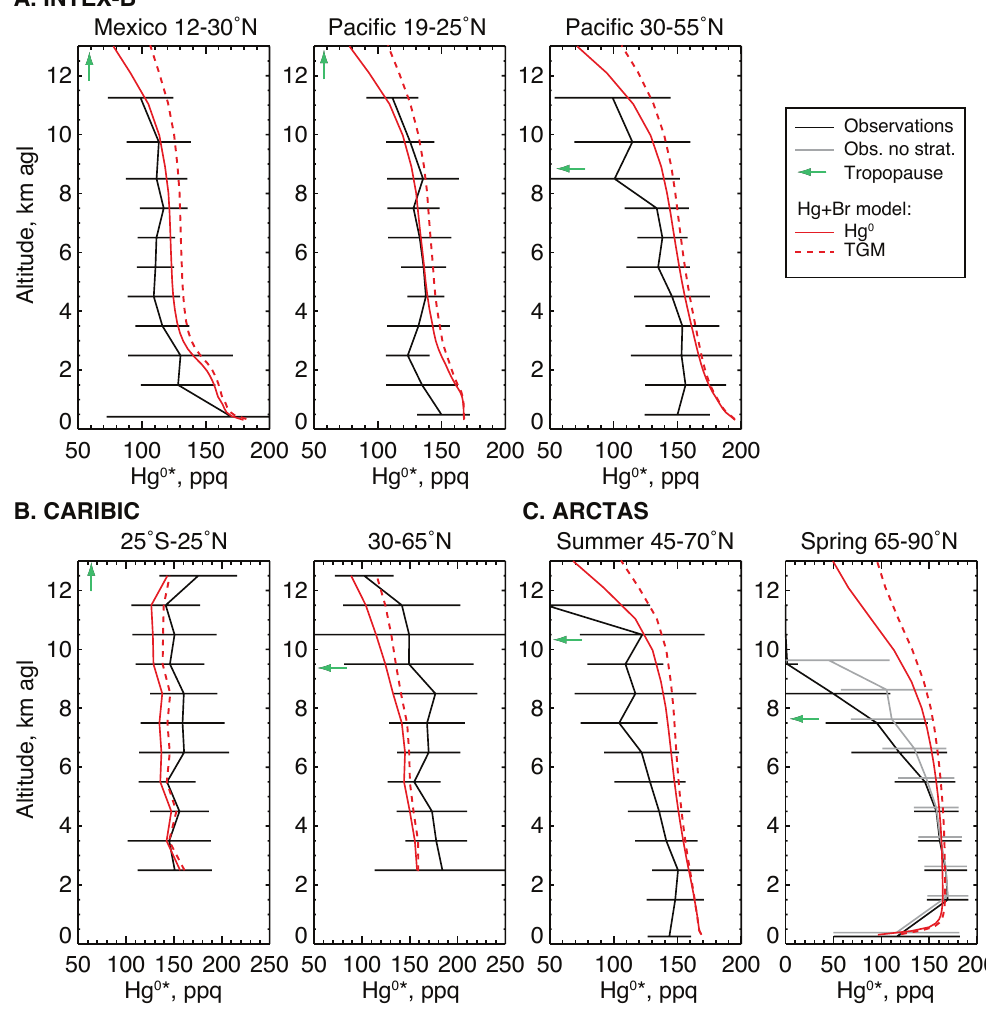
Fig. 11. Mean vertical profiles and standard deviations of mercury concentrations measured by aircraft and compared to the Hg+Br model. (A) INTEX-B over Mexico during March 2006 and over the North Pacific Ocean during April–May 2006 (Talbot et al., 2008; Singh et al., 2009). We correct a low bias of 40% in the observations based on an in-flight intercomparison (Swartzendruber et al., 2008). (B) CARIBIC flights over Europe, Asia, Africa, and the Atlantic Ocean during 2005–2008 (Slemr et al., 2009). (C) ARCTAS flights over North America and the Arctic Ocean in summer 2008 (45–70 ◦ N) and spring 2008 (65–90 ◦ N) (H. Mao et al., 2010). Arrows show observed mean tropopause (O 3 =100ppb). Gray lines in the lower right panel show data for troposphere only. Model results show Hg 0 and TGM monthly mean mixing ratios over each flight region (INTEX-B and ARCTAS) or instantaneous values along the flight track (CARIBIC). Altitudes are above ground level. Note the different horizontal scales. See text for definition of Hg 0 ∗